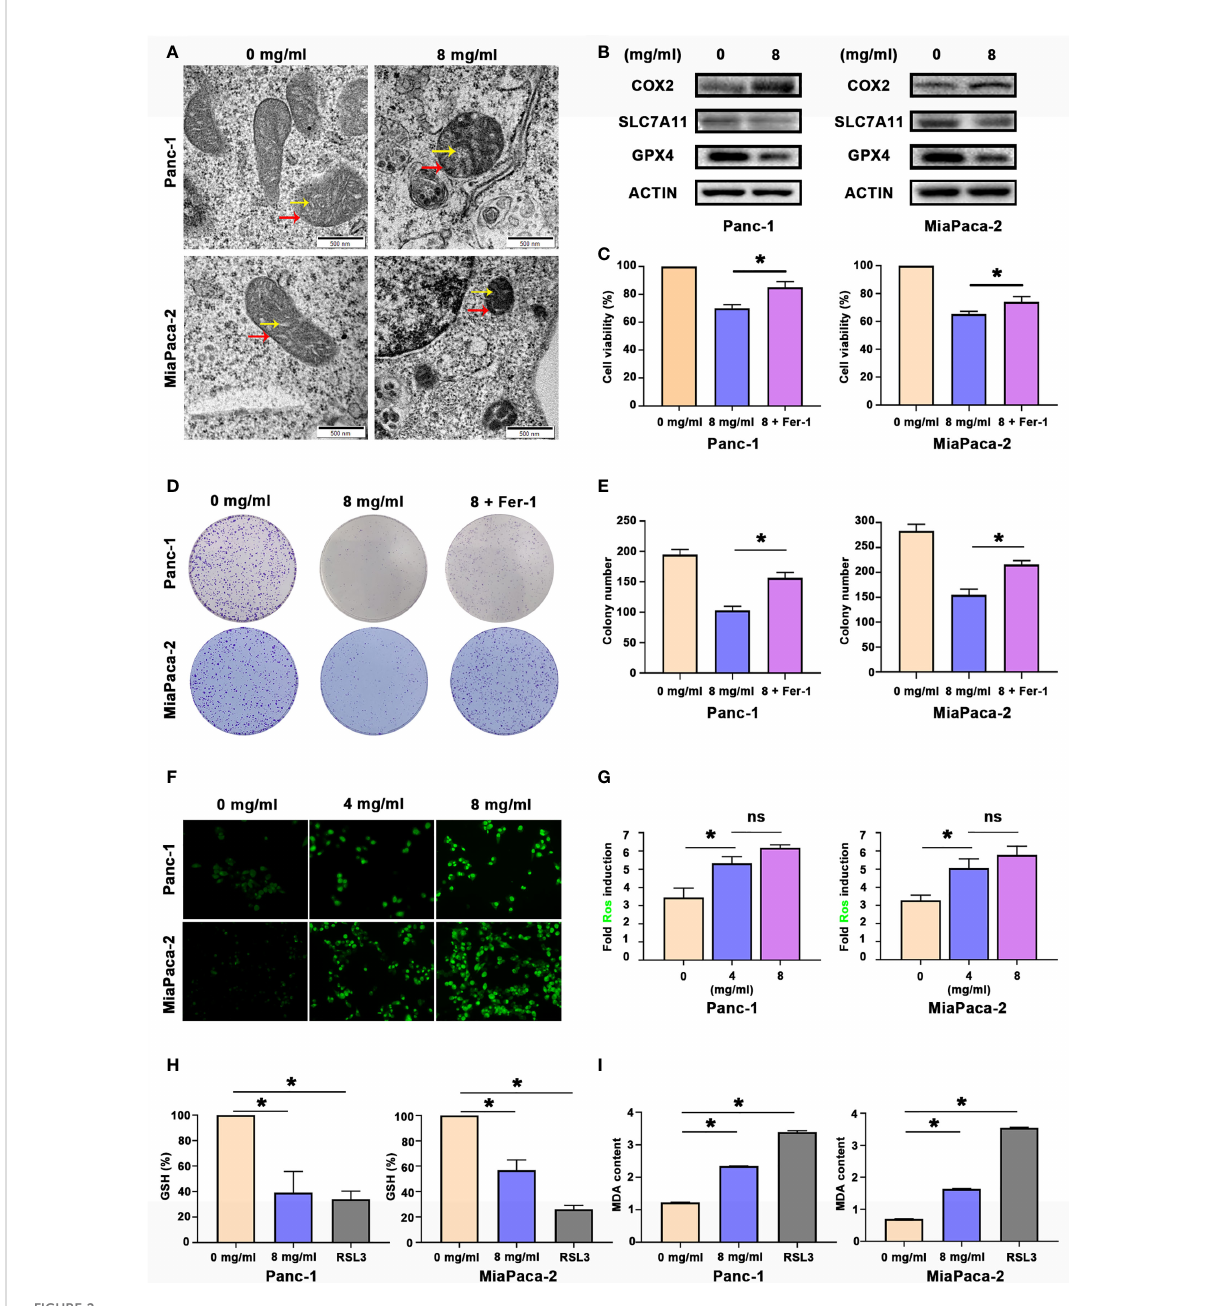
FIGURE 2 Huaier inhibited pancreatic cancer cell proliferation in vitro by inducing ferroptosis. (A) TEM images showing the mitochondria in Panc-1 and MiaPaCa-2 cells after the Huaier treatment (the yellow arrow re fl ects cristae, and the red arrow re fl ects the outer membrane). (B) Western blotting showing the protein levels of COX2, SLC7A11 and GPX4 in Panc-1 and MiaPaCa-2 cells after the Huaier treatment. (C) CCK8 assay showing the viability of Panc-1 and MiaPaCa-2 cells after the control, Huaier and Huaier plus ferrostain-1 (Fer-1) treatments for 96 h. (D, E) Colony formation assay and its statistical analysis showing the cell proliferation of Panc-1 and MiaPaCa-2 cells after the control, Huaier and Huaier plus Fer-1 treatment for 2 weeks. (F, G) Immuno fl uorescence-based DCFH-DA staining and statistical analysis showing the intracellular ROS levels in Panc-1 and MiaPaCa-2 cells after treatment with various concentrations of Huaier. (H, I) The measurement of GSH and MDA concentrations in Panc-1 and MiaPaCa-2 cells after the control, Huaier and RSL3 treatments. ns P > 0.05, *P < 0.05, scale bar = 500